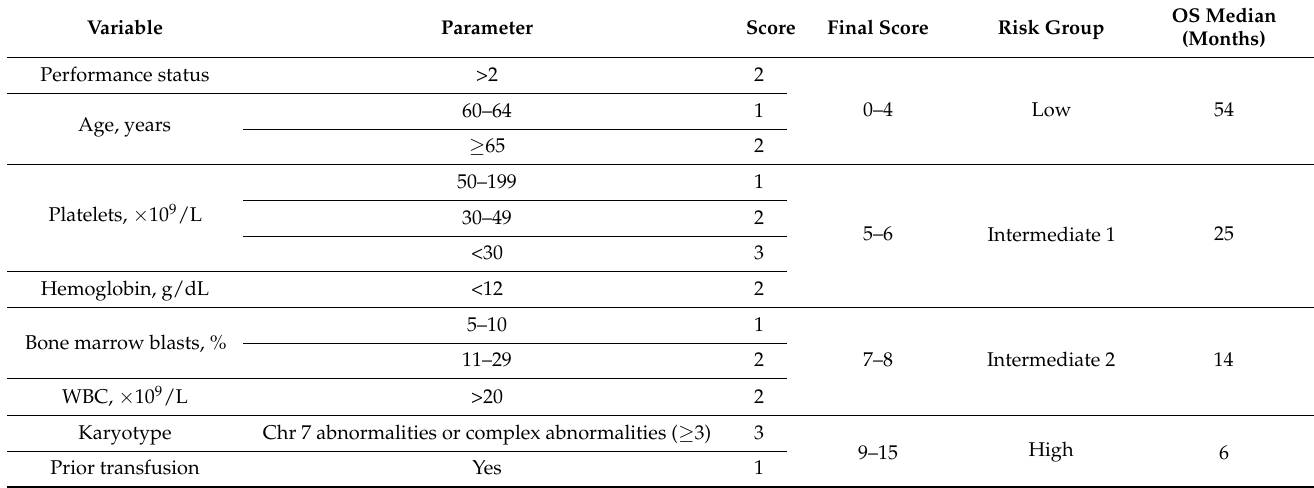
Table 3. MD Anderson Prognostic Scoring System (MDASS). Adapted from Kantarjian et al., Cancer, 2008